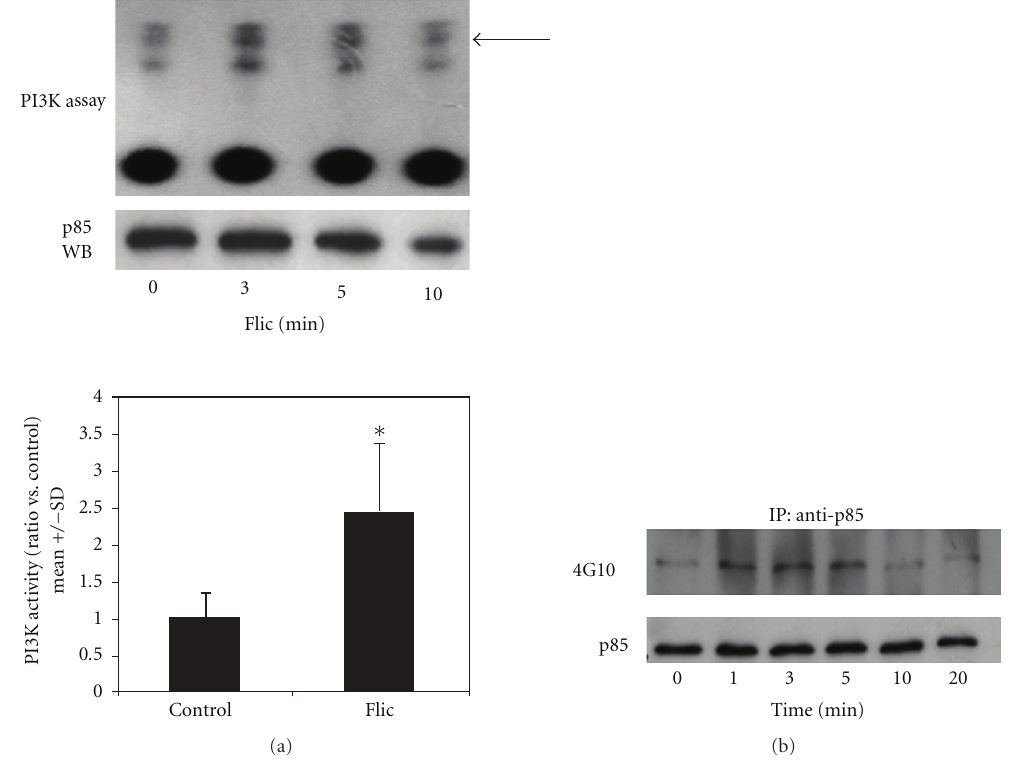
Figure 1: Activation of PI3K in Caco-2 cells by E. coli flagellin. (a) In vitro kinase assay. Caco-2 cells treated with flagellin (FliC) 1 μ g/ml for the indicated times were lysed and immunoprecipitated with anti-p85. An aliquot of each immunoprecipitate was analyzed by Western blot for p85, and the remainder was reacted with phosphatidylinositols and γ - 32 P-ATP and separated by thin-layer chromatography. The PIP3 band is indicated by the arrow. Densitometry performed on autoradiograms from three independent experiments is shown below. ∗ P < . 05, FliC versus control ( t -test). (b) Tyrosine phosphorylation of PI3K. Caco-2 cells treated with 500 ng/ml flagellin for the indicated times were lysed and immunoprecipitated with anti-p85. Precipitates were separated by SDS-PAGE and Western blots performed using 4G10 antiphosphotyrosine. Blots were stripped and reprobed with anti-p85 to confirm equal e ffi ciency of immunoprecipitation. Results are representative of two separate